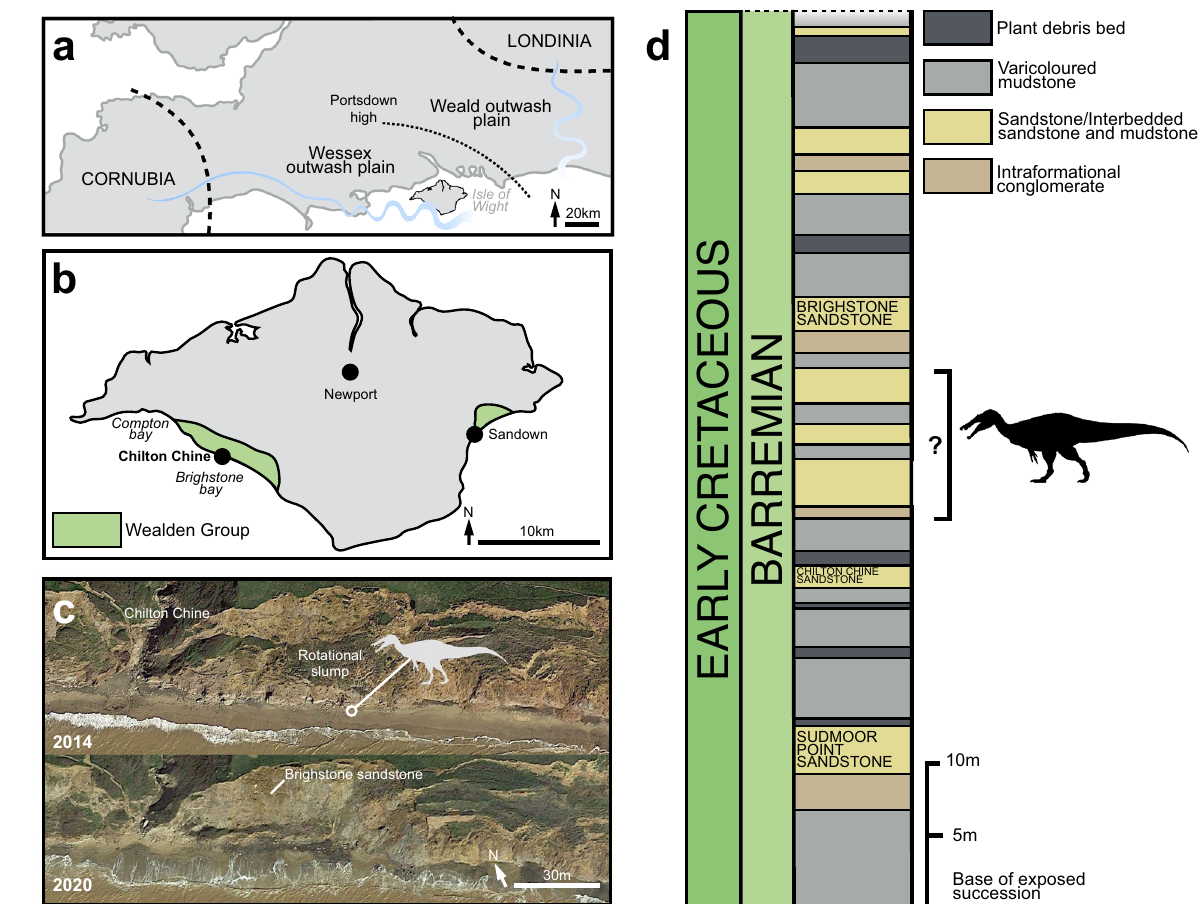
Figure 2. Locality information and stratigraphy of Chilton Chine. ( a ) Schematic palaeogeographic map of the Wessex and Weald sub-basins of southern England (modified from Penn et al., 2020); ( b ) map of the Isle Wight, highlighting the location of Chilton Chine and Wealden Group outcrops; ( c ) aerial photographs of Chilton Chine, highlighting the approximate position of the in situ material referred to Riparovenator milnerae (see SI) and the extensive coastal processes affecting the locality since the initial discoveries (map data: Google, Landsat/ Copernicus, TerraMetrics, Maxmar Technologies); ( d ) schematic lithological log of the base of the exposed Wessex Fm. at Brighstone Bay (modified from Sweetman et al. 2014), highlighting approximate position of the R. milnerae in situ material. Silhouette credit: Dan Folkes (CC-BY